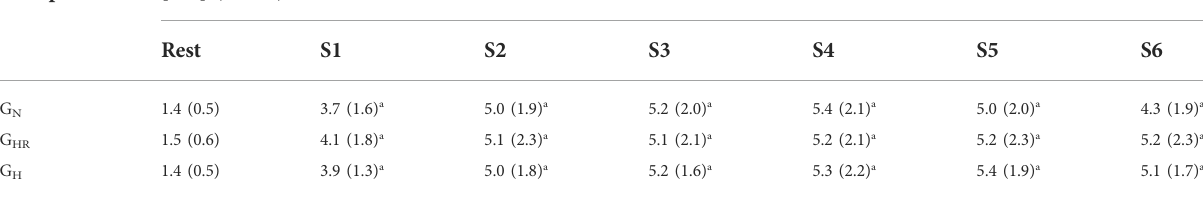
TABLE 5 Mean absolute lactate concentration ([La − ]) in each set over the 8 weeks of intervention. Group [La − ] (mmol) Rest S1